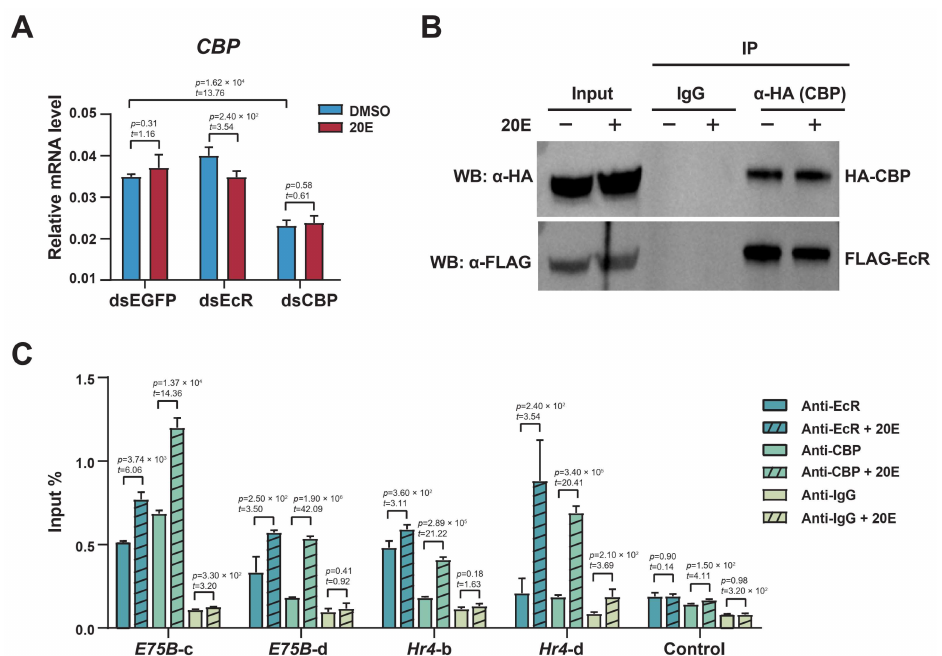
Figure 6. Ecdysone receptor (EcR) cooperated with CBP-mediated histone acetylation in response to 20E. ( A ) RT-qPCR of CBP expression in BmE cells first treated with dsRNA against EGFP, EcR, or CBP, then either left untreated or exposed to 20E for 12 h. We calculated the ratios of RNA levels of the gene of interest to those of RP49 . Error bars: standard error of the mean (SEM) from three biological replicates measured in duplicate. Student’s t -test (df = 4). ( B ) CBP interacted with EcR in the presence of 20E. DMSO- or 20E-treated BmE cells were cotransfected with HA-CBP and FLAG-EcR. Extracts were immunoprecipitated with HA (using the HA IP antibody). The immunoprecipitates were analyzed via Western blotting. ( C ) ChIP-qPCR analysis of EcR, CBP, and IgG in DMSO- or 20E-treated BmE cells. DNA was quantified using primers designed to amplify the putative regulatory elements of E75B and Hr4 gene loci, as shown in Figure 1C,E. Error bars: standard error of the mean (SEM) from three biological replicates measured in duplicate. Student’s t -test (df =